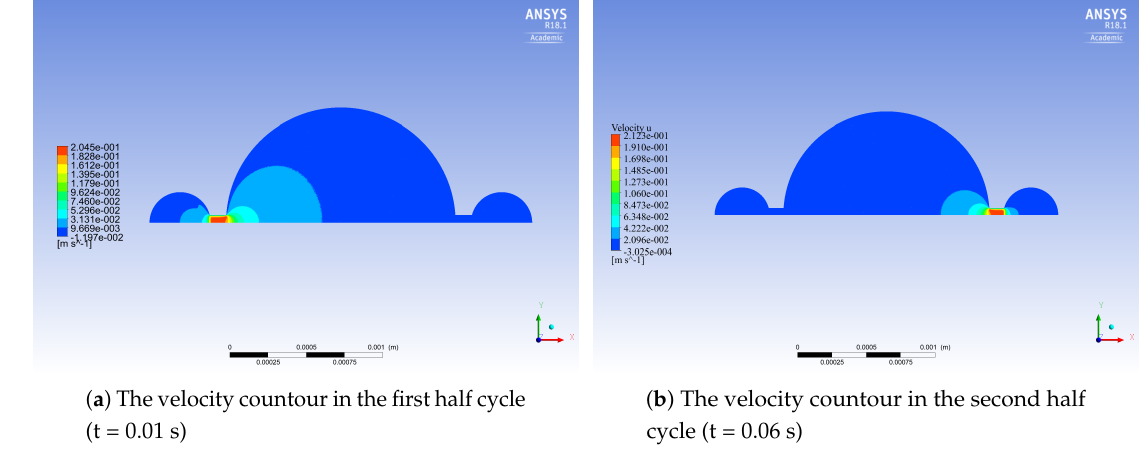
Figure 9. The velocity profiles in the midplane of the micropump.